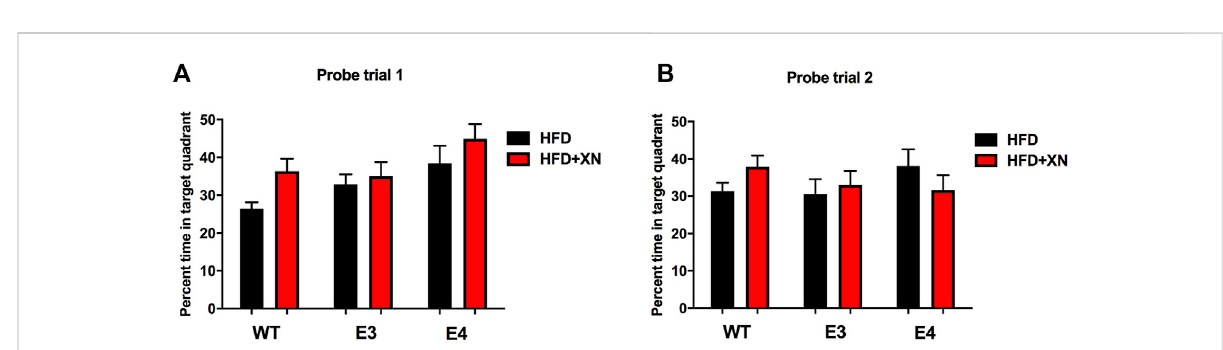
FIGURE 4 Spatial memory retention in the fi rst (A) and second (B) probe trials. Between sessions 8 and 9 of the water maze, and after session 10, the platform was removed from the pool during probetrials. Mice spending more time in thepart of the pool where the platform was located